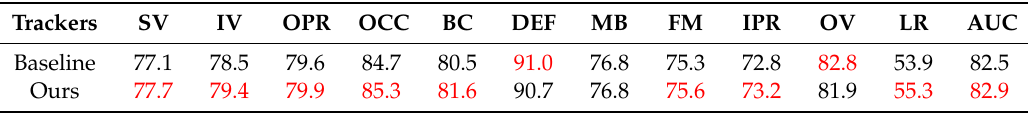
Table 2. Overlap accuracy and average accuracy of the proposed tracker and baseline tracker in 11 di ff erent attributes. Red represent the better